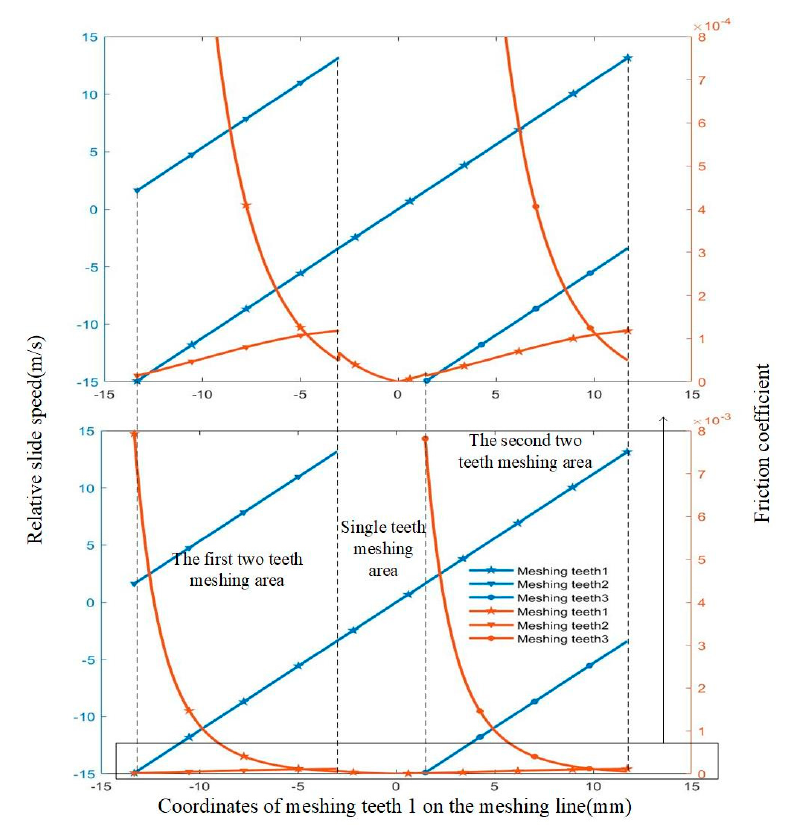
Figure 4. Relative slide velocity and friction coefficient during the meshing process.